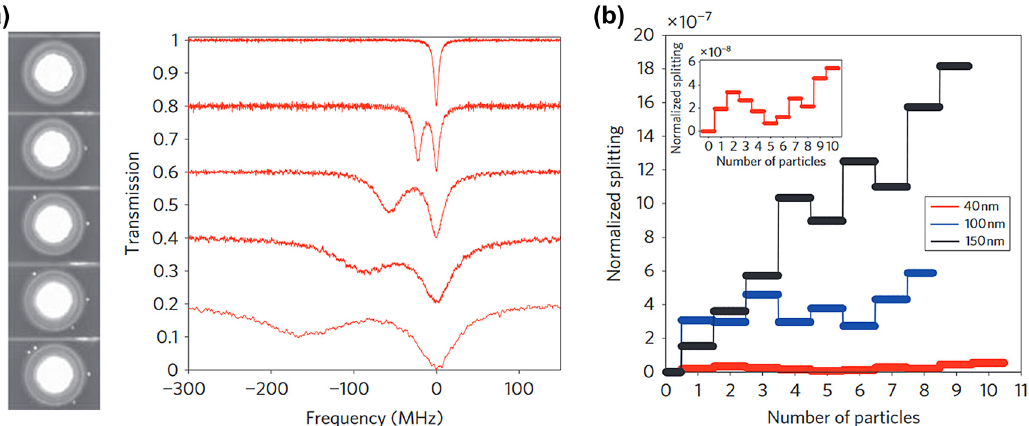
Figure 16: (a) Series of transmission spectra recorded with successivedepositions of nanoparticles. (b) Splitting distance versus the number of nanoparticles boundto the microcavity ’ s surface. Reprinted by permissionfrom Springer Nature:Nature Photonics [323], copyright